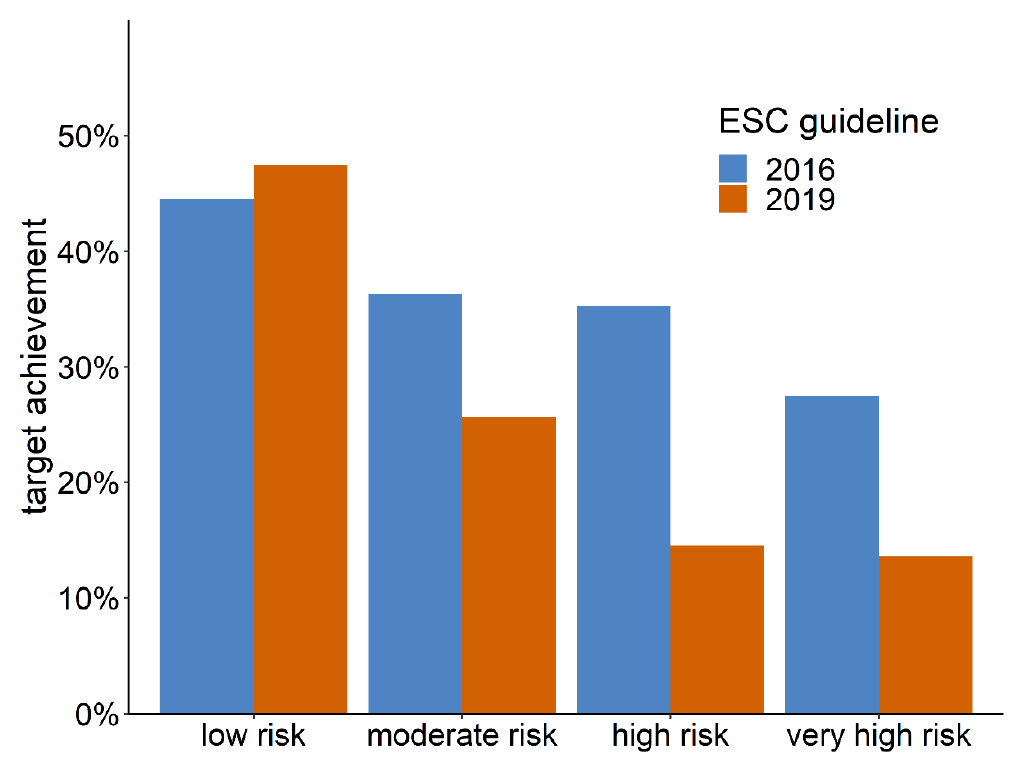
Figure 3. LDL-C target achievement stratified by guideline and risk category.